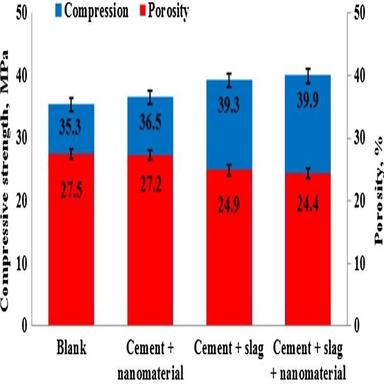
Compressive strength and porosity of different additives with cement solidified samples.